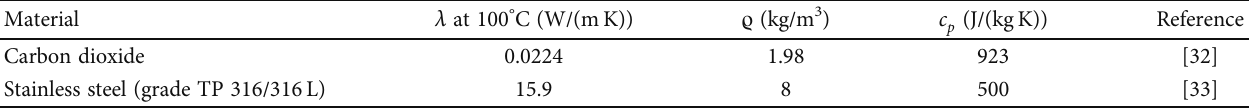
at constant pressure of carbon dioxide and stainless steel. p (J/(kg K)) Reference p